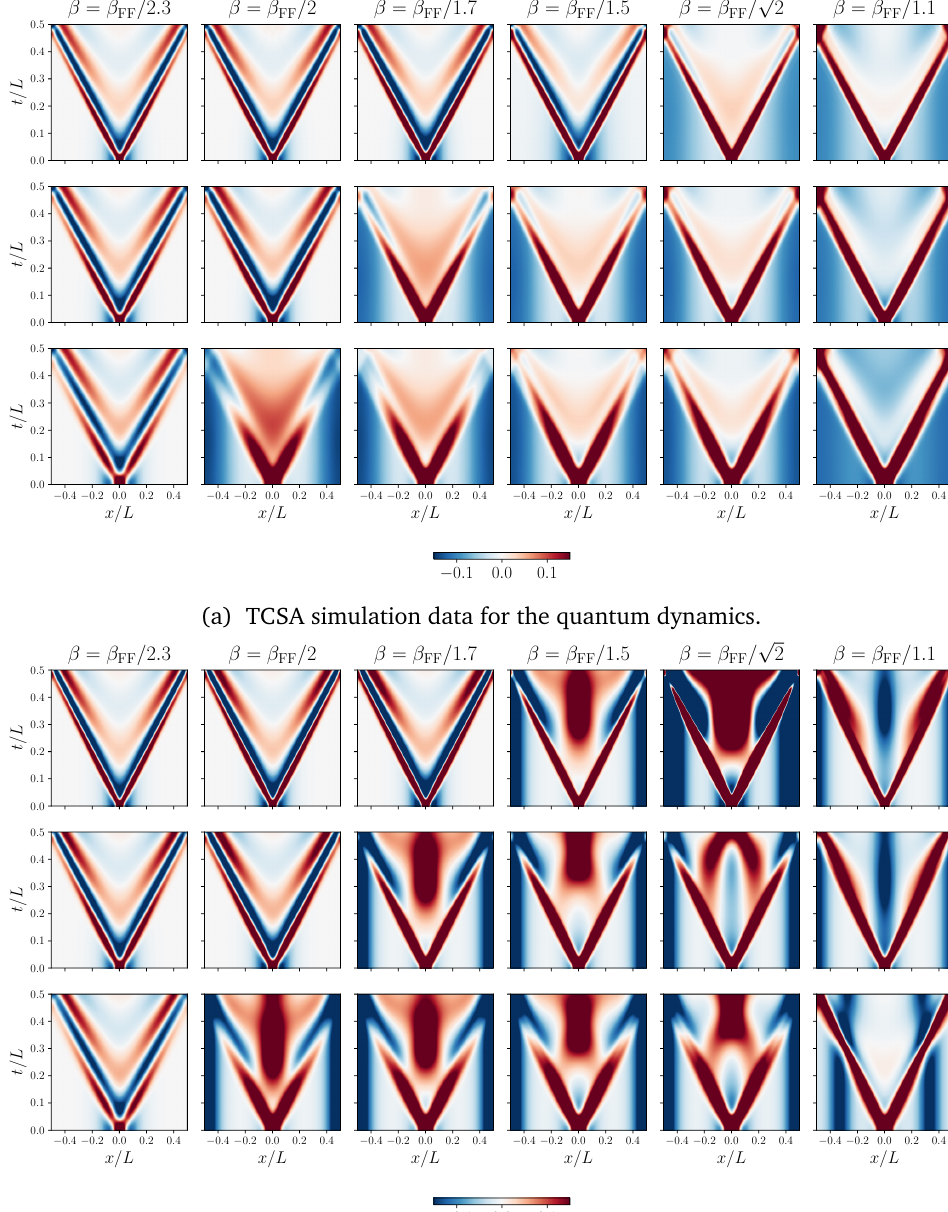
Figure 4.6: Space-time density plots of the time evolution of the topological density in the (a) quantum system (TCSA simulation) and in the (b) classical model. The plots correspond to each of the three different cases of external sources j ( x ) and chosen β values. (First row: A β σ = 4 / 9, third row: A β m 1